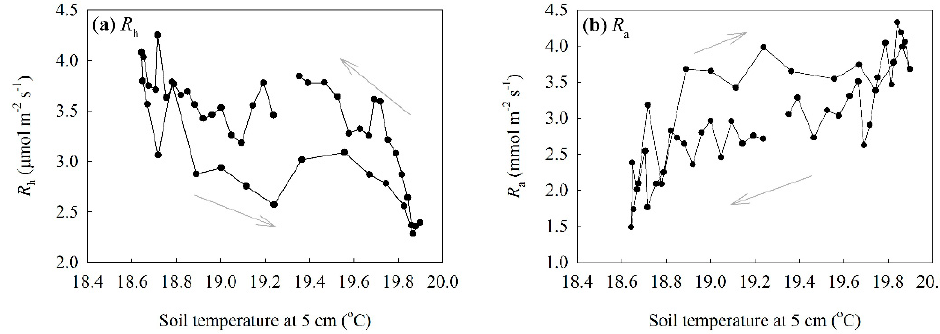
Figure 9. The relationship between soil temperature and soil respiration at diel scale: ( a ) variation of R h with soil temperature; ( b ) variation of R a with soil temperature.